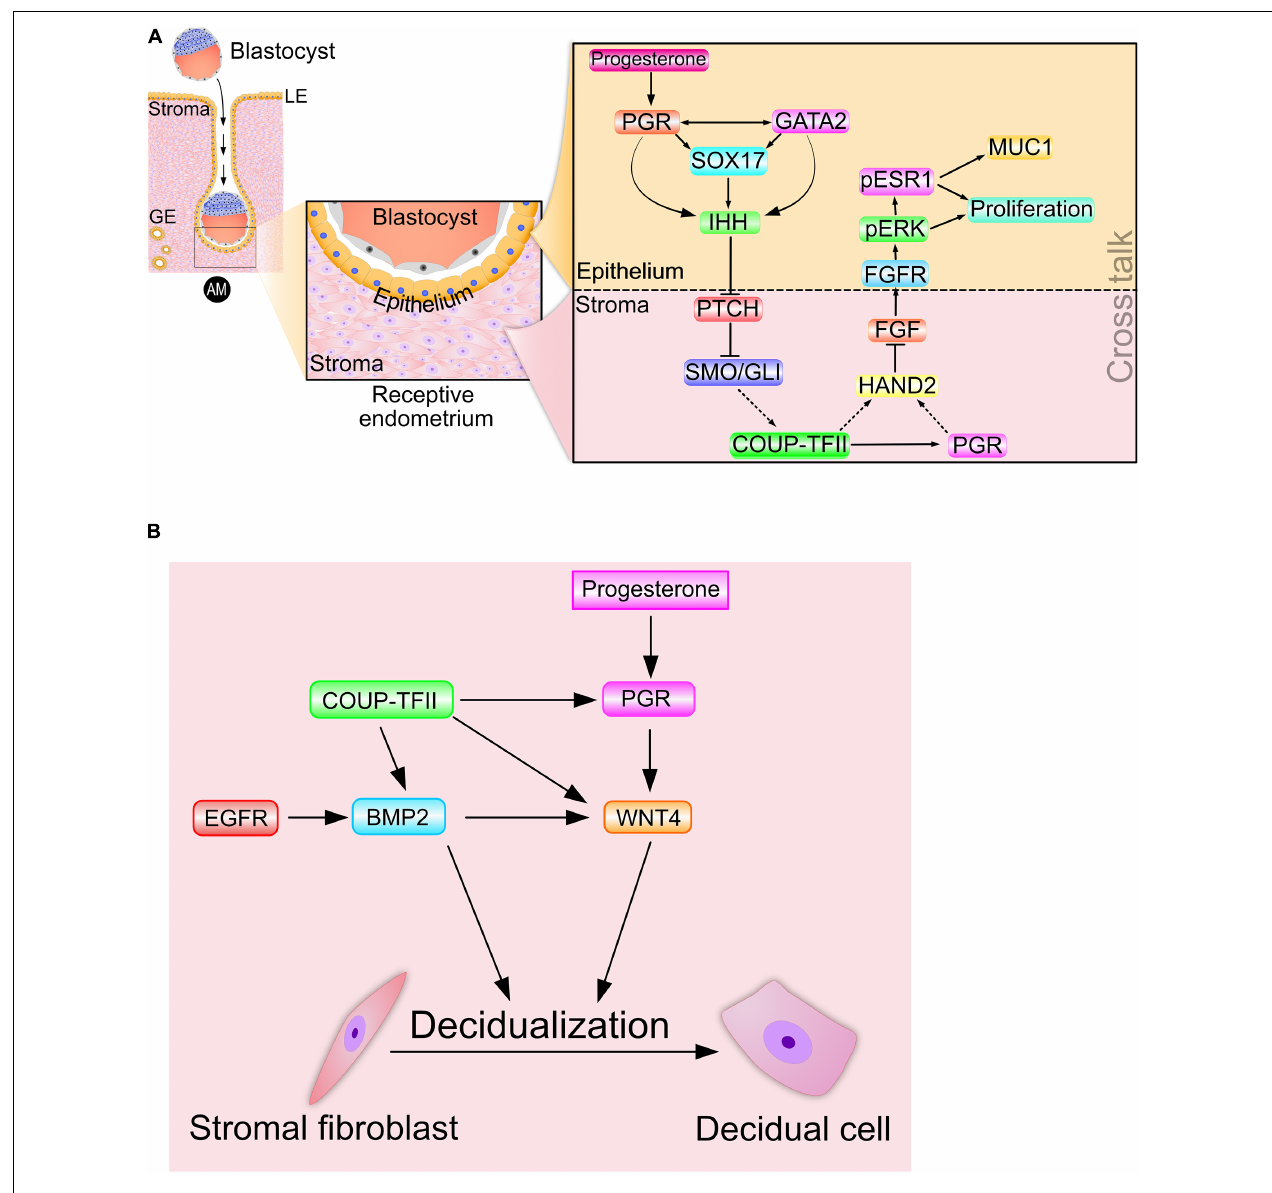
FIGURE 2 | Signaling cross talk drives progesterone-dependent endometrial receptivity and decidualization. (A) Spanning the epithelial-stromal divide of the endometrium, the progesterone-PGR-IHH-COUP-TFII signaling axis primarily controls ESR1 activity in the epithelium. Suppression of ESR1 activity is a prerequisite for luminal epithelial differentiation of the endometrium to be receptive to embryo attachment and implantation. Note: Msx 1 and 2—and many other important mediator signals—that are important in this process are not shown. (B) A representative signaling network that is essential for progesterone driven endometrial stromal cell decidualization is shown. The dotted arrows indicate signaling relationships for which direct regulatory control has yet to be established. Adapted with permission in modified form from Wu et al. (2018).